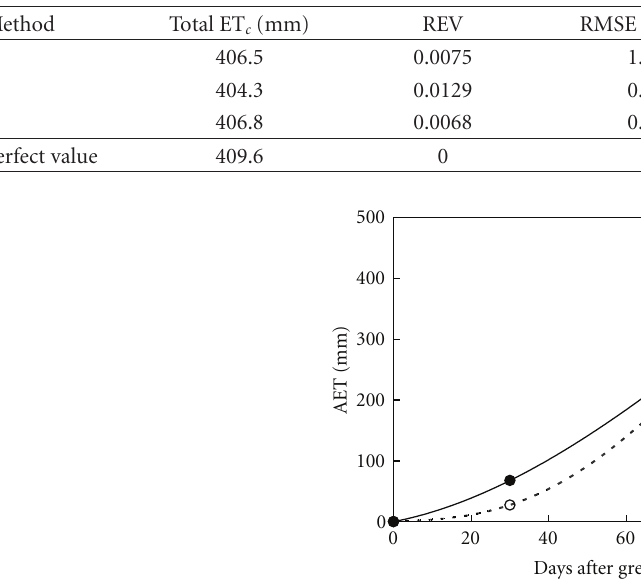
Table 3: Evaluation of di ff erent disaggregation methods.